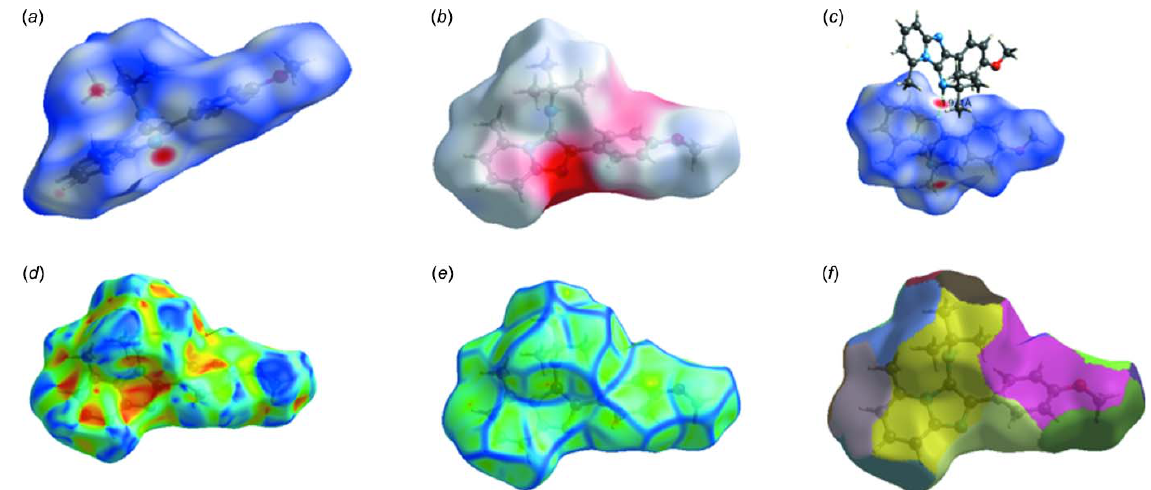
Figure 6 View of the Hirshfeld surface for compound (I), mapped over: ( a ) d norm ; ( b ) electrostatic potential; ( c ) intermolecular contacts; ( d ) shape index; ( e ) curvature; ( f ) fragment patches.